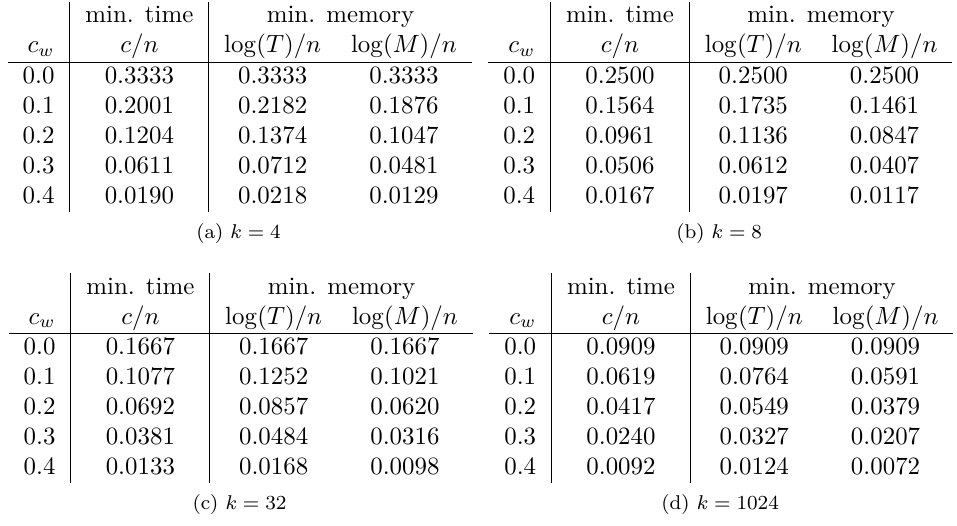
and memory consumption expo- n